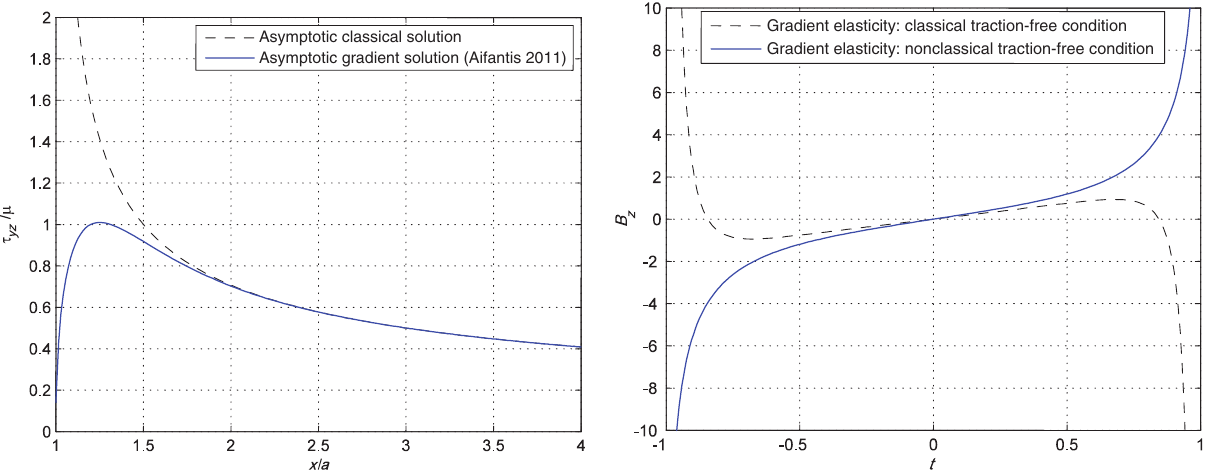
Figure 4: Asymptotic stress fields around the crack tip, ℓ = 0.2 a (Aifantis,